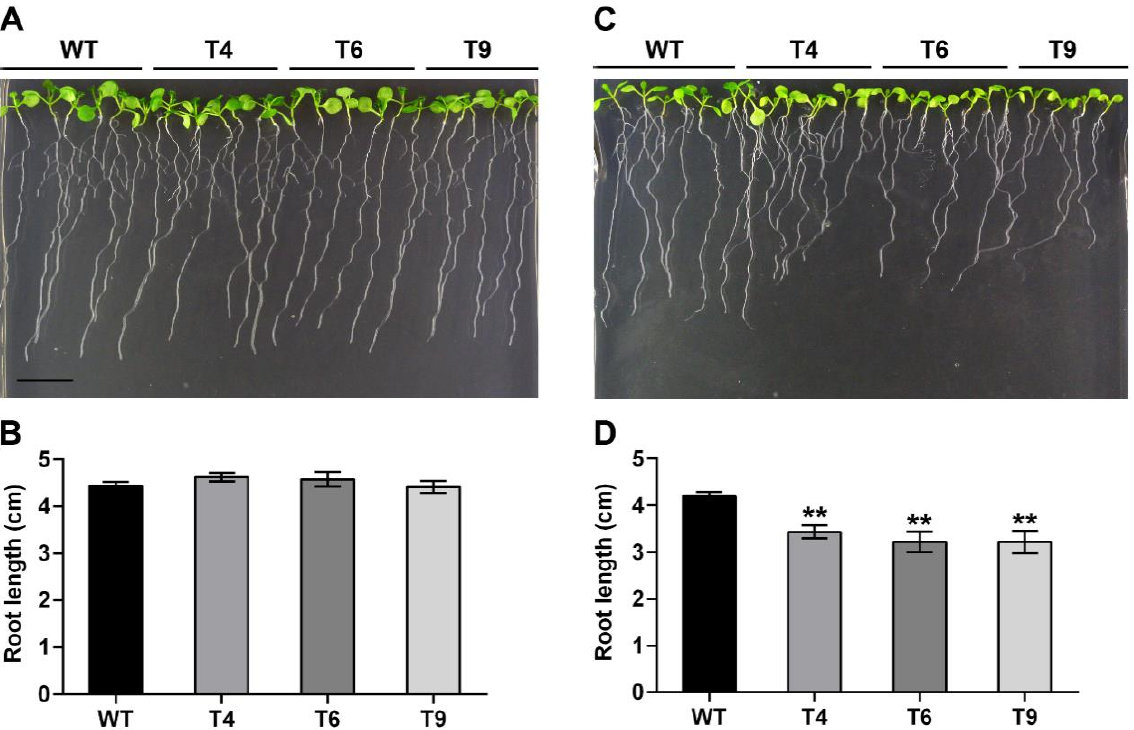
Figure 13. Effects of ABA stress on root length of FtMYB22 transgenic Arabidopsis (T4, T6, and T9) lines and WT lines. ( A , B ) Root length under normal conditions. ( C , D ) Root length under ABA condition. WT, wild-type. Data are presented as mean and SD values of three independent experiments. Error bars indicate SD. ** means extremely significant difference at p < 0.01 level.